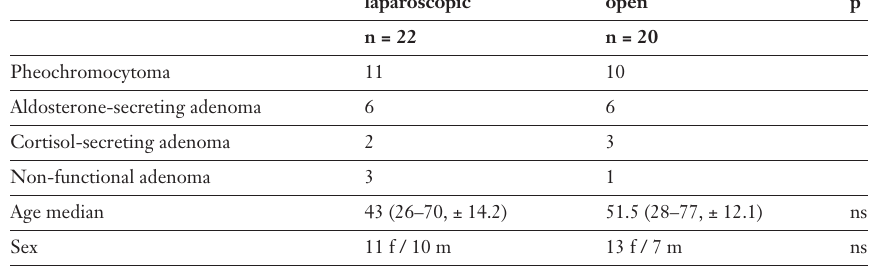
Operating time, hospital stay, blood loss and analgesic